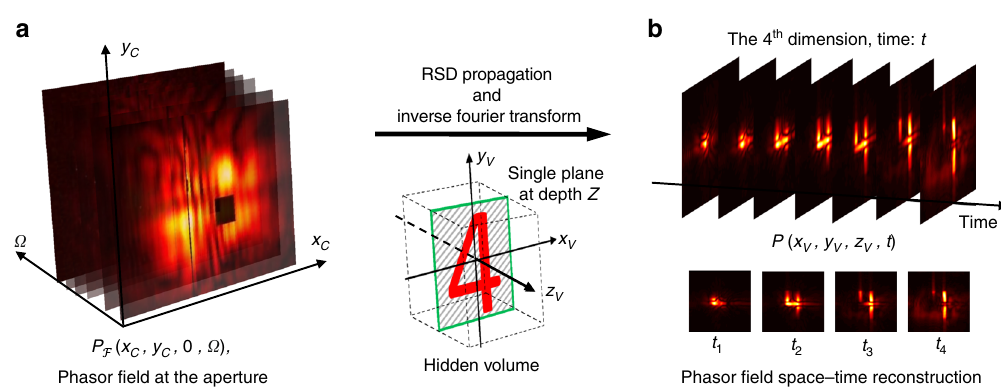
Fig. 3 Space-time wave propagation using RSD. a The phasor fi eld collected at the aperture forms a spatial frequency cube. Given the output plane, by using the RSD propagation model, we can recover the hidden wavefront at any time instance. b This space-time wave propagation method where one can reveal a spherical wavefront that moves into the hidden scene. Even though ( b ) only shows reconstruction at a single depth plane, our proposed method can be generalized into the three-dimensional volume as well, which leads to a four-dimensional reconstruction